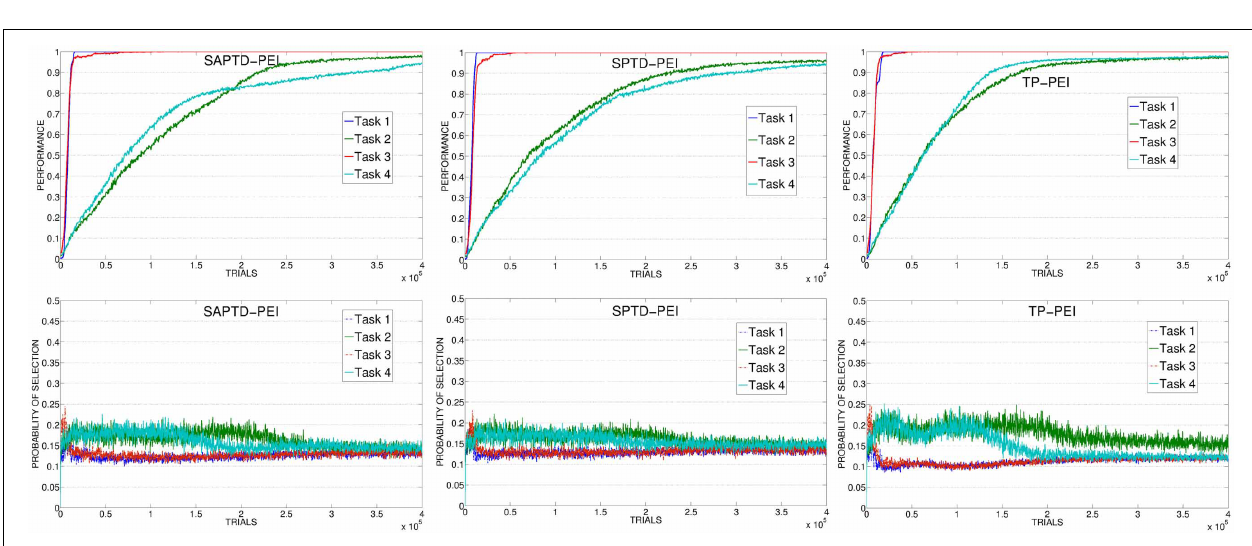
FIGURE 13 | Average performance on the 4 learnable tasks (top) and average selection probability for the associated expert (bottom) in the best condition (with respect to the learning rate) of SAP-TD-PEI, SP-TD-PEI, TP-PEI.